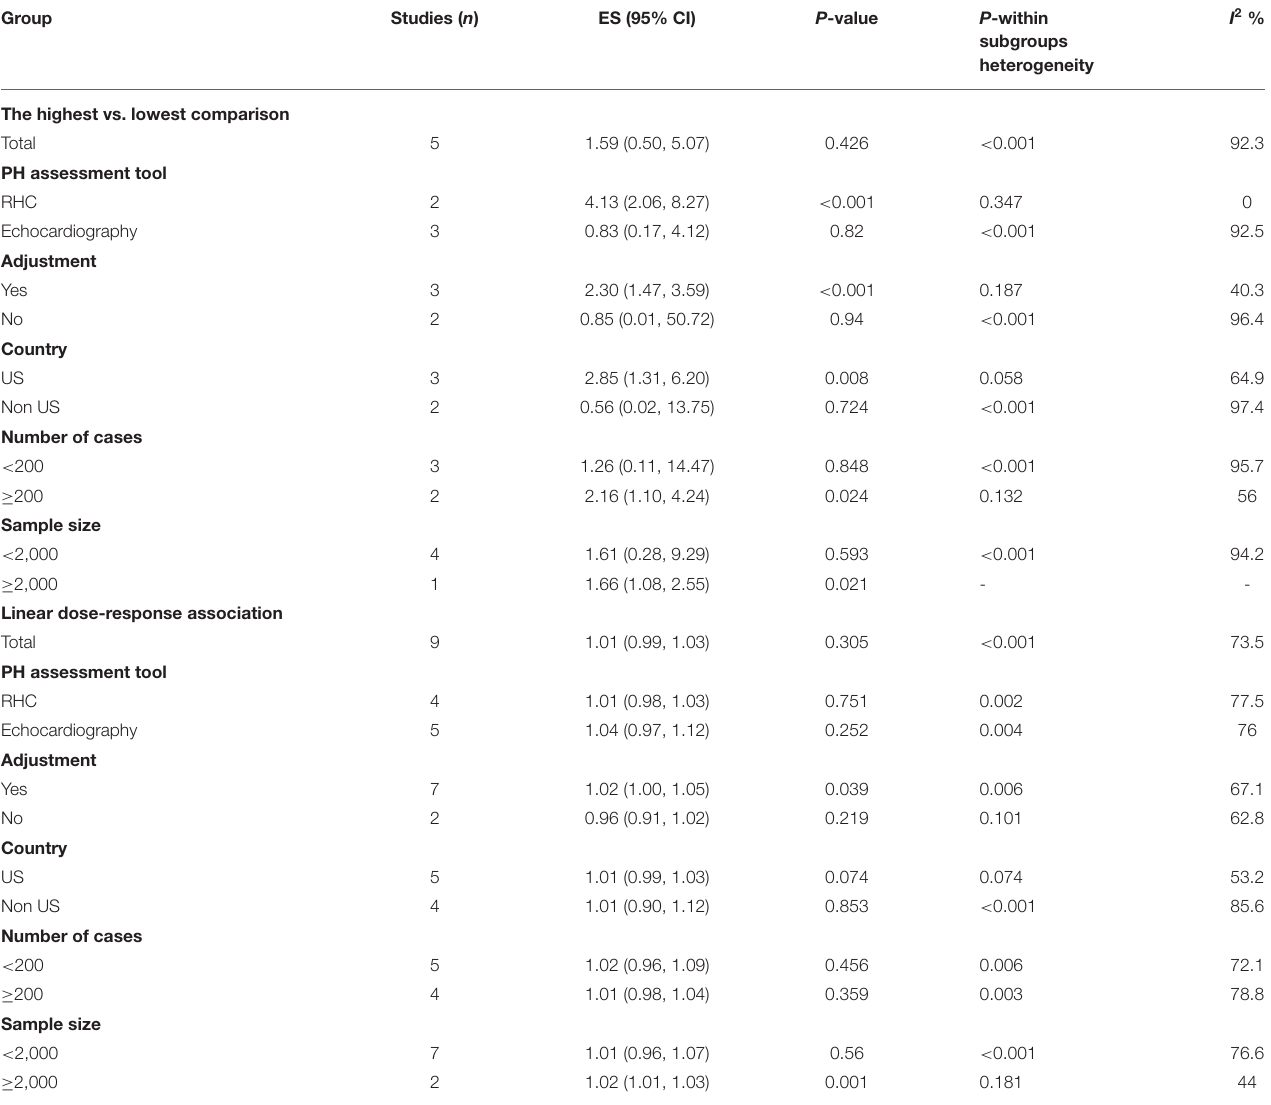
subgroups heterogeneity